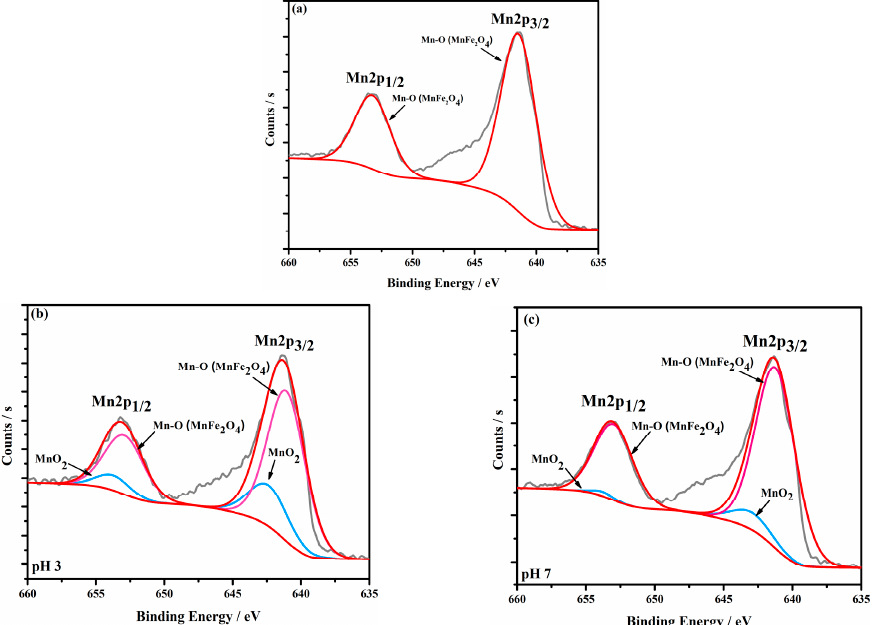
Figure 9. The Mn2p decomposition spectra of MnFe 2 O 4 ( a ), MnFe 2 O 4 − Cr (pH = 3) ( b ) and MnFe 2 O 4 − Cr (pH = 7) ( c ).